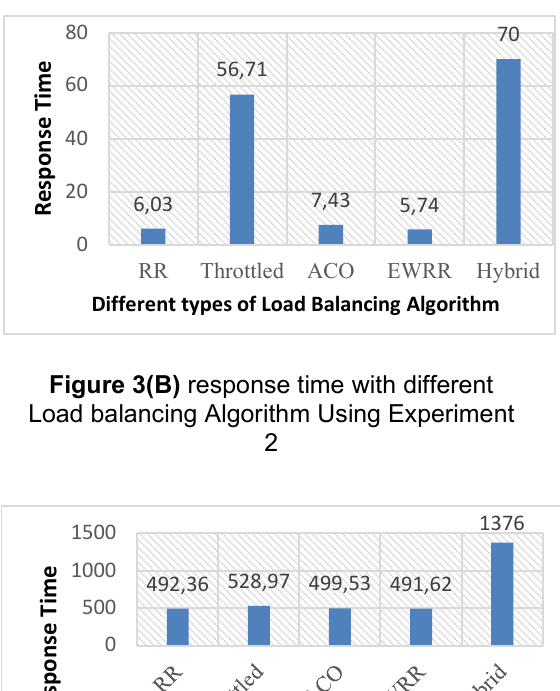
Different types of Load Balancing Figure 3(A) response time with different Load balancing Algorithm Using Experiment 2